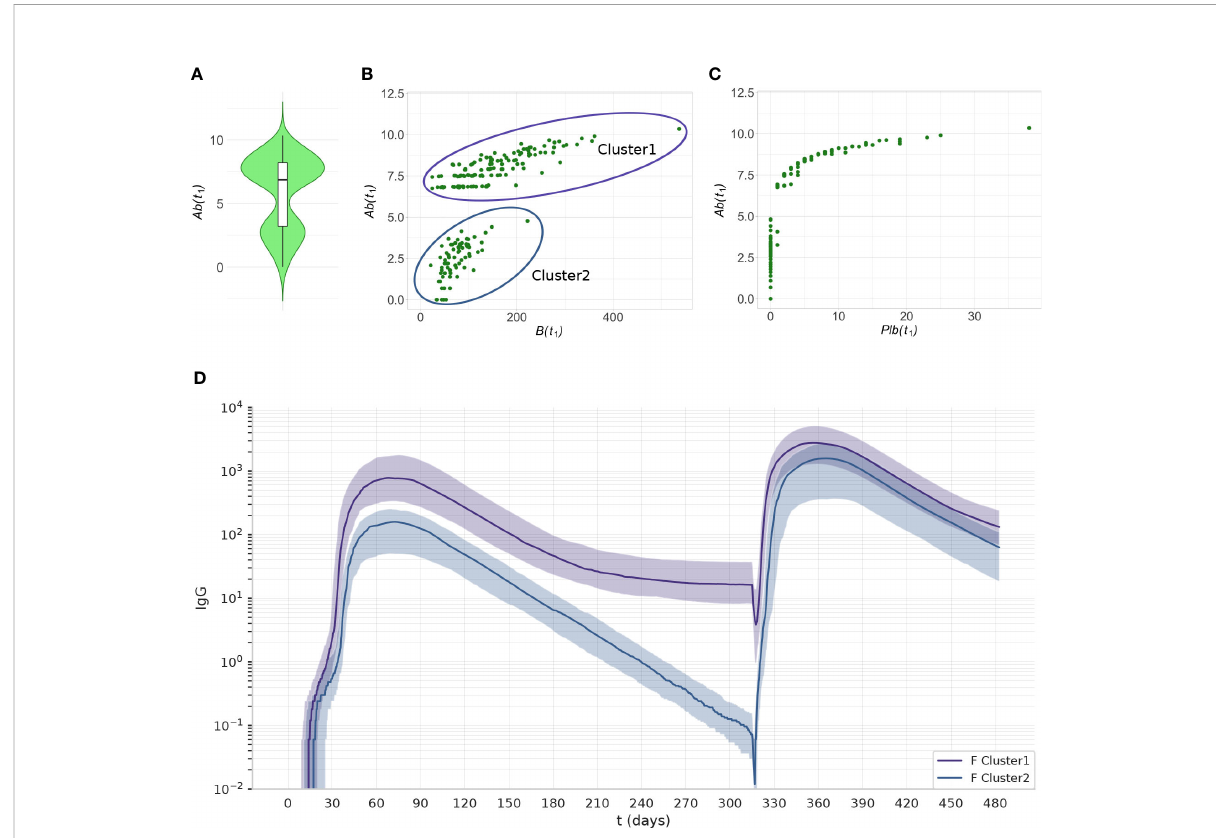
FIGURE 9 The two clusters identi fi ed by PCA can be separated by their level of Ab ( t 1 ) Data from experiment 1C are reported. (A) The violin plot of Ab ( t 1 ) reveals two clusters with different levels of Ab. (B) The scatterplot shows that the individuals with low antibody levels have, in most cases, no plasma cells. (C) the scatterplot shows that the individuals with low levels of antibody have memory B cells. (D) The antibody dynamics of the two clusters is different, cluster 1 represents antibody sustainers , and cluster 2 represents antibody decayers . The plots represent the median (lines) and IQR (shaded area) of variable Ab in cluster 1 and cluster